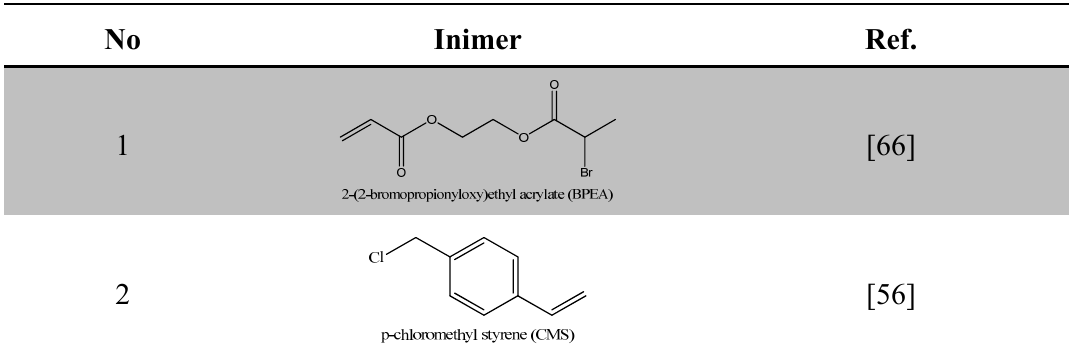
Table 3. Inimer molecules employed for the synthesis of grafted hyperbranched polymers on silica particles by self-condensing vinyl